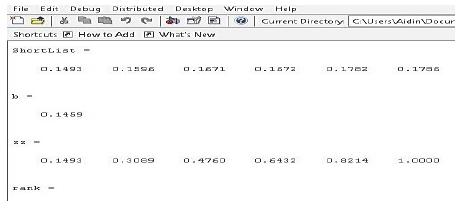
Fig. 5. Increasing the chance of visiting more elite layouts through searching process